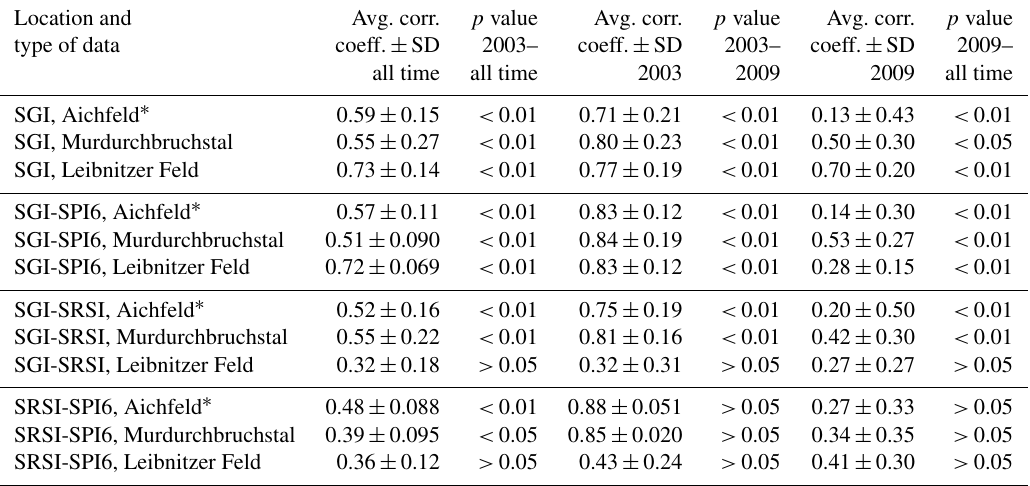
Table 3. Average Pearson correlation coefficients of a subregion for SGI time series with each other, SGI time series with the SPI6 and SGI time series with SRSI with their standard deviations for each subregion for the complete time series, during drought (2003) and flood (2009) conditions. Also shown is the p value indicating the statistical significance of the difference between the correlation coefficients between the full time period, drought and flood